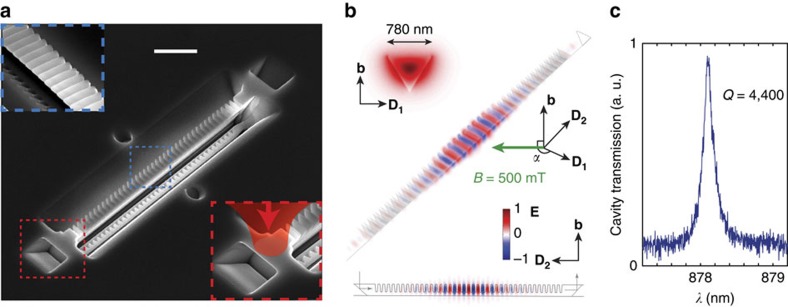
Photonic crystal nanobeam resonator fabricated in Nd:YSO.(a) Scanning electron microscope image of the device. Scale bar, 2 μm. The red inset is a zoomed-in view of the 45° angle-cut coupler that allows vertical coupling of light from a microscope objective. The blue inset shows the grooves forming the photonic crystal. (b) Schematics of the nanobeam resonator with simulated electric field (E along D1) profiles of the fundamental TE resonance mode. The TE polarization aligns with the D1 axis of the YSO crystal. A magnetic field of 500 mT is applied in the D1–D2 plane at an angle of α=135° with respect to the D1 axis. (c) Broadband cavity transmission spectrum showing the cavity resonance with quality factor Q=4,400.